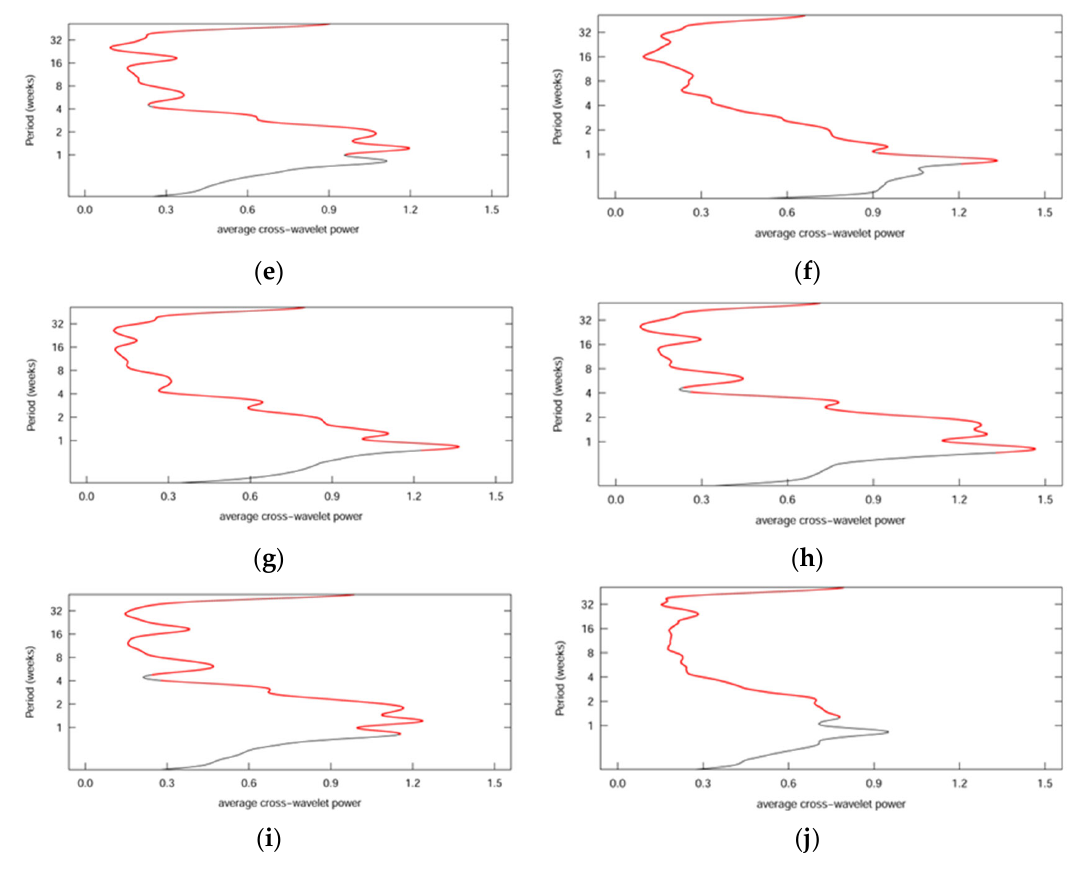
Figure A2. Average cross-wavelet power. Note: the red dots are at the 5% significance level. ( a ) Beijing–Zhangjiakou. ( b ) Beijing–Chengde. ( c ) Beijing–Tianjin. ( d ) Beijing–Langfang. ( e ) Beijing– Baoding. ( f ) Chengde–Zhangjiakou. ( g ) Tiannjin–Chengde. ( h ) Langfang–Tiannjin. ( i ) Baoding– Langfang. ( j ) Baoding–Zhangjiakou.